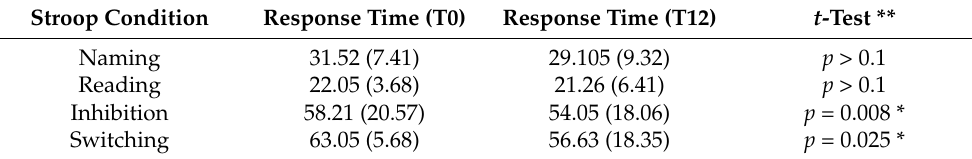
Table 2. Response time for four conditions of the Stroop test for the study population ( n = 19). Stroop Condition Response Time